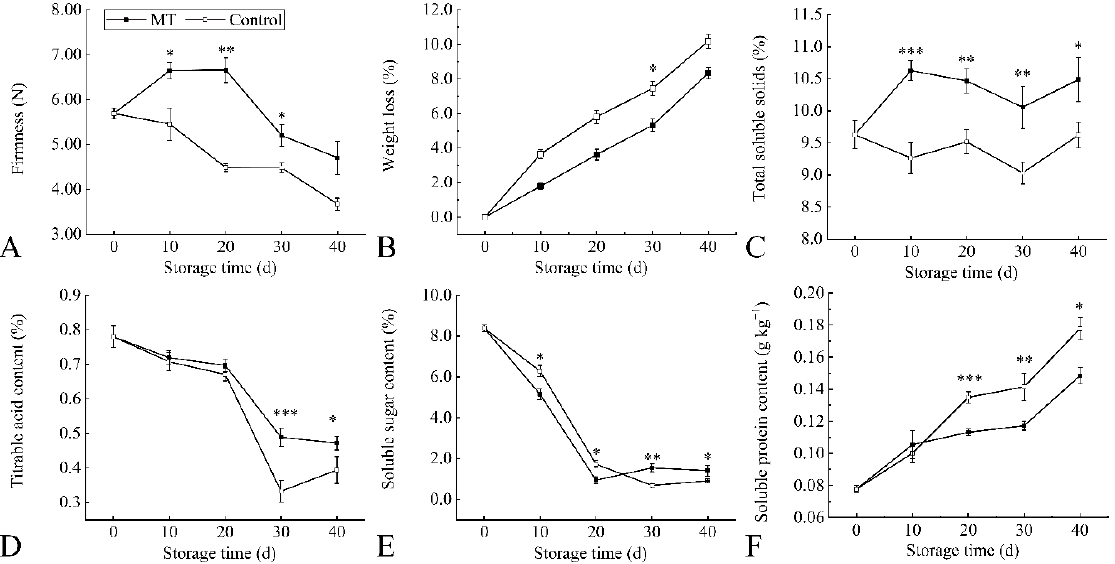
Figure 5. Melatonin treatment affects fruit quality during storage. Changes in firmness ( A ), weight loss ( B ), total soluble solids ( C ), titratable acid content ( D ), soluble sugar content ( E ), and soluble protein content ( F ). Values represent mean ± standard deviation based on three independent bio- logical replicates. * represents p < 0.05 for significance between treatments, ** represents p < 0.01, *** represents p < 0.001.